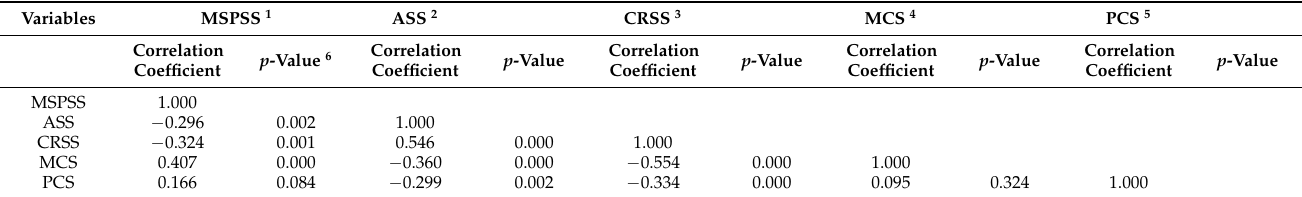
Table 2. Bivariate correlation coefficients among the main variables ( n = 109).